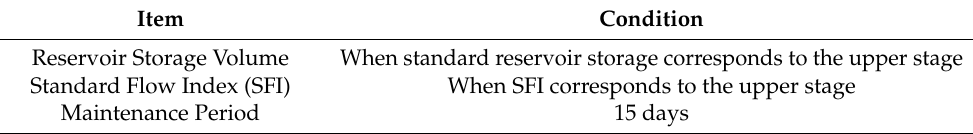
Table 3. Termination Criteria at Each Drought Response Stage [4].